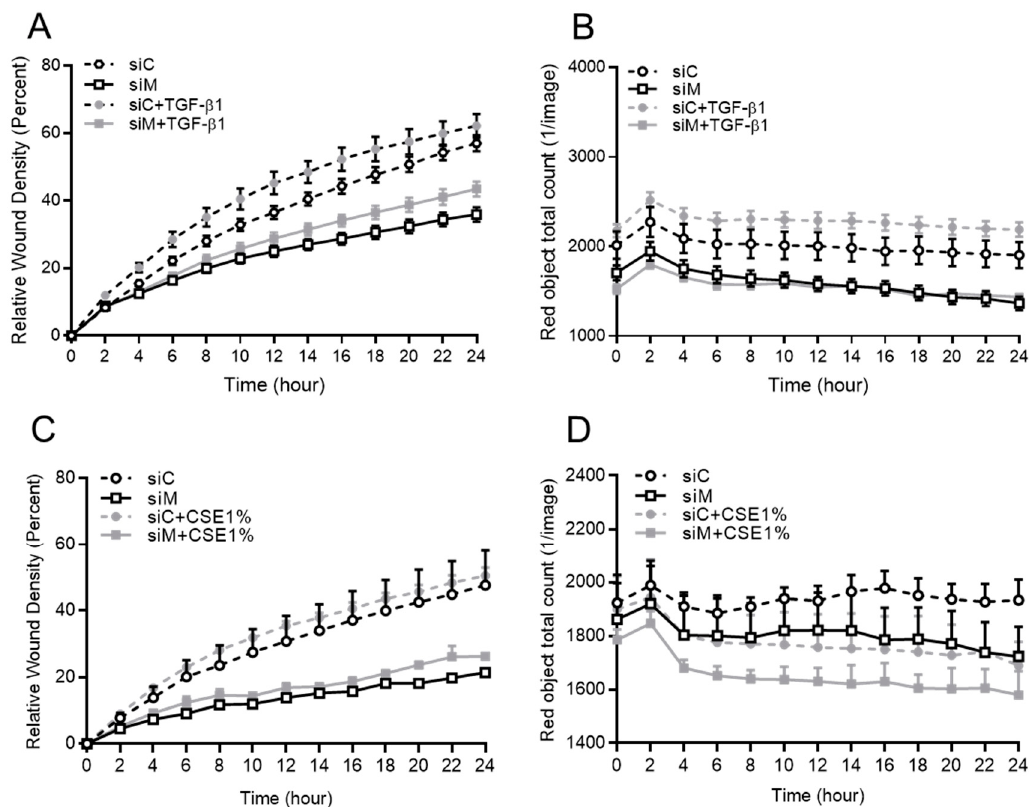
Figure 7. Role of Ezrin, AKAP95, and Yotiao in TGF- β 1-induced cell migration while using BEAS-2B cells. ( A , C ) Cell migration was monitored every two hours in a 96-well plate using a real time system Incucyte. ( B , D ) Cell proliferation was monitored by Incucyte. The BEAS-2B cells were transfected with a combination siRNA of Ezrin, AKAP95, and Yotiao together with 3 ng / mL TGF- β 1 and 1% CSE exposure. Data representative of 3–5 independent experiments. The data are expressed as mean ± SEM.